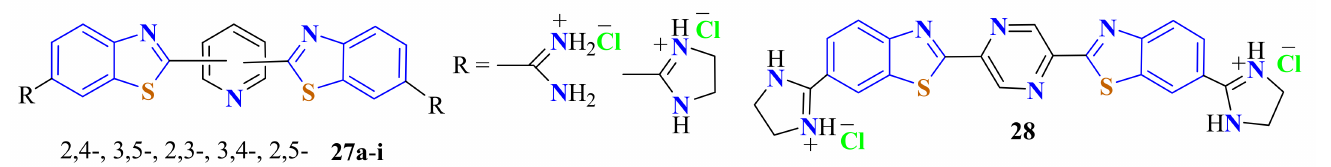
Figure 7. Amidinobenzothiazolyl-disubstituted pyridines and